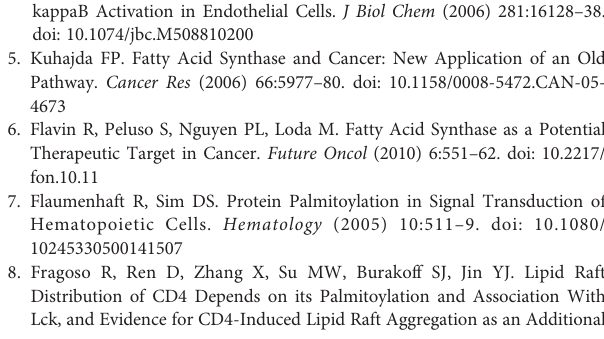
SUDHL10 and Raji cells. (G) Scatter plot represents fold changes in the gene expression from the transcriptome of TVB3166 or 3657 or cerlulenin treated bNHL cells (no signi fi cant difference were detected in the gene expression pattern with cerulenin treatment performed in the presence of 1% or 10% serum containing medium, data notshown),withwhiskers showingtherange ofthe outliers,withmax and min values as O and the 1 and 99th percentile outliers as X. Individual data points are shown on the left of box plots as fi lled circles. Dotted red lines show the 1.2 log2 fold-change cutoff. Supplementary Figure S2 – S3 | GSEA analysis of global biological responses to FASN inhibition. Network representation of Gene Set Enrichment Analysis (GSEA) for Reactome gene sets for (A) cerulenin or (B) and S3 for TVB3166 or TVB3567 treatment, 48 hours versus untreated control bNHL cells, SUDHL2, SUDHL4, SUDHL10 and Raji cells. Leading edge analysis with a FDR<0.05 determined signi fi cant gene sets enriched for each group. The size of each node re fl ects the amounts of genes involved for each gene set. The edge thickness (green lines) represents the number of genes associated with the overlap of two gene sets (or nodes) that the edge connects. Clusters in each grouping were named according to common functions. Upregulated gene sets denoted with red color and downregulated gene sets were denoted by blue color. Supplementary Figure S4 | Metabolic and key gene responses to cerulenin treatment in bNHL cells. (A) Line graphs represents spectrophotometric detection of NADPH appearance (y-axis) as rate of change in OD (optical density at 340nM wavelength from cell-free enzyme assays consisting increasing concentrations of NADP (x-axis) comparing PGDH alone or PGDH+FASN catalyzed reactions. (B) Lineweaver-Burk plot represents PGDH reaction velocity in the presence of increasing NADP concentration, and the effect of coupling this reaction with FASN enzymatic activity. (C) Key signi fi cant genes and network analysis identi fi ed from transcriptomic analysis of cerulenin treated with SUDHL10 cells reveal interactions occurring between G6PDH (NADPH generating PPP, rate-limiting enzyme from fi rst step) and NADPH dependent enzymes GSR, TXNRD1 and NQO1 with FASN inhibition. (D) Schematic representation of pentose phosphate pathway steps associated with NADPH generation. (E) Bar graphs represents log fold change (y-axis) in G6PDH, GSR, TXNRD1, NQO1 genes expression induced by cerulenin treatment in multiple bNHL cells (x-axis), (F) Western blot analysis show changes in protein levels associated with key gene responses to cerulenin treatment in NHL cells. (G) Annexin-V staining for apoptosis and analysis by fl ow cytometry show that cerulenin and 5FU combination results in increased cell death compared to single agent treatments in SUDHL10 cells at 96 hours. Supplementary Table S1 | Pathway enrichment by multi-omic analysis comparing cerulenin transcriptome and metabolome. List of pathways determined using signi fi cant genes and metabolites from cerulenin treated SUDHL10 cells analyzed based on pathway centrality and degree of enrichment for determination ofhighimpactpathwaysshowninFigure2E, isincludedinthistable.Impactscores, FDR, P values, number of molecules and hits are included in this table. Supplementary Table S2 | Concentration of nucleotide pools in cerulenin treated bNHL cells. Quantitative mass spectrometry analysis of cerulenin treated bNHL cells, normalized per million cells, represented in m M or *ion